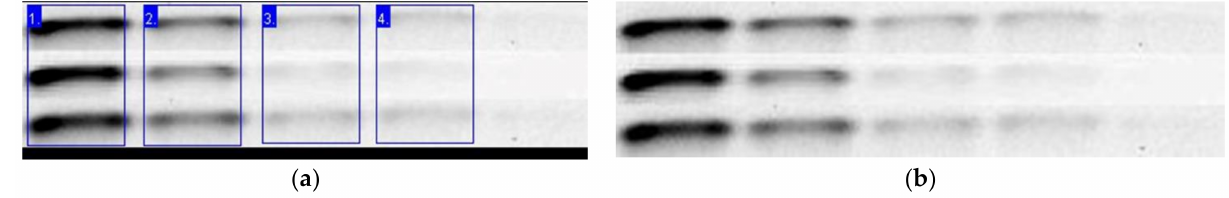
Figure 5. Gel image analysis: ( a ) band image; ( b ) exp #1 band